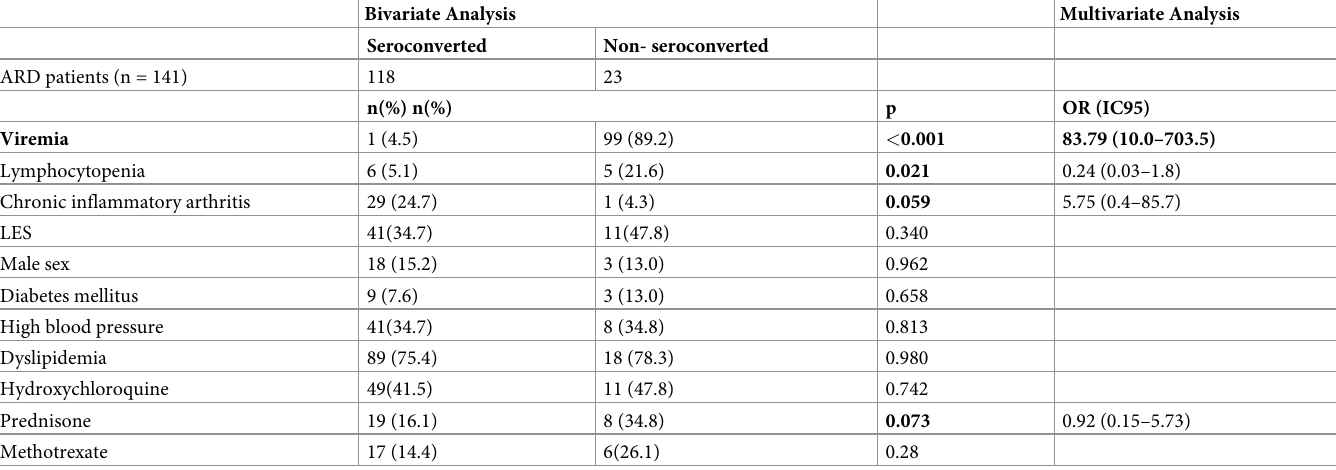
Table 4. Analysis of factors associated with seroconversion 30 days after fractional-dose yellow fever vaccine (YFV) in ARD patients. Bivariate Analysis Multivariate